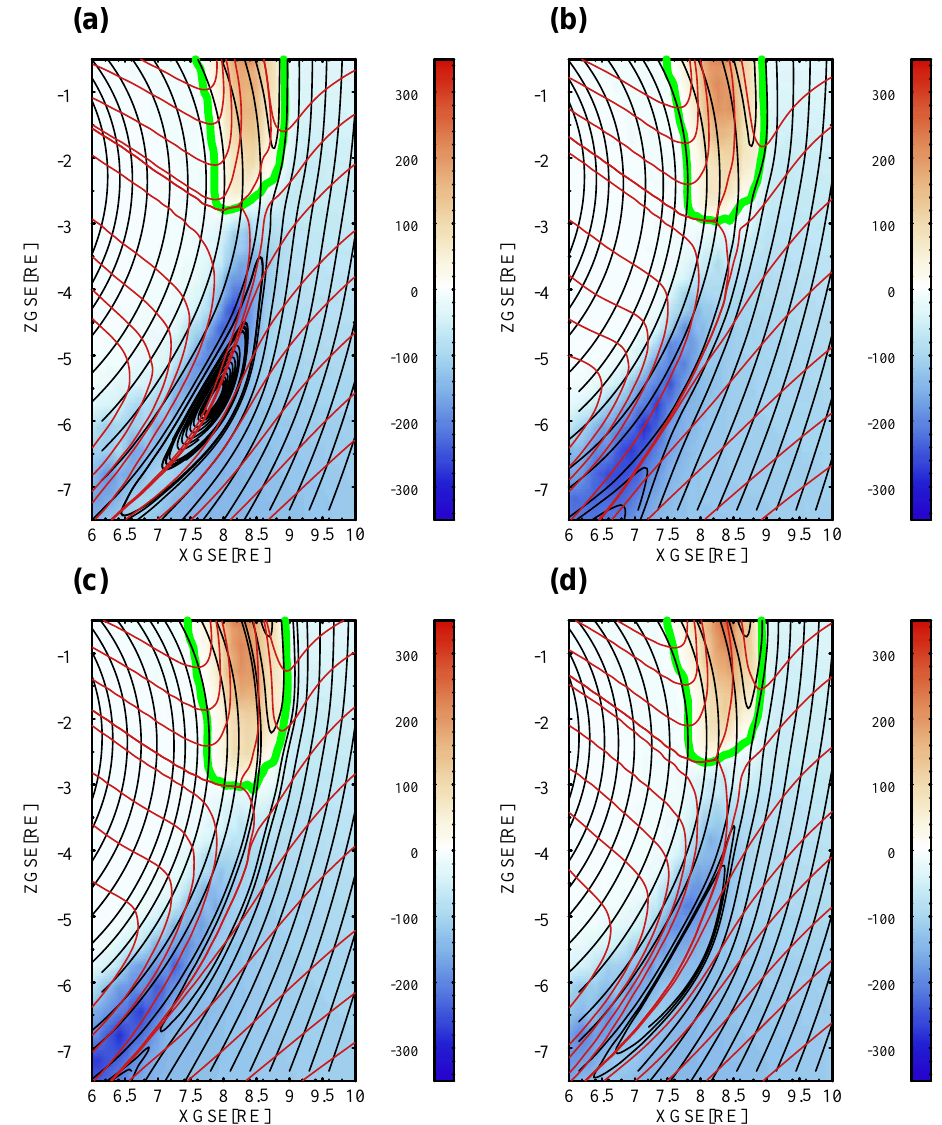
Fig. 3. The four panels show cuts in the noon-midnight meridional plane at different times. In each of the panels the color coding represents the Z-component of the plasma velocity in km/s. The thick green line is the zero contour of the plasma velocity Z-component. The black lines are field lines, i.e., these lines are tangent to the magnetic field direction in the Y=0 plane. The red lines are flow lines, i.e., these lines are tangent to the instantaneous velocity direction in the Y=0 plane. These snapshots were taken at different times: (a) t=t 0 =3260s, (b) t=3360s=t 0 +100s, (c) t=3400s=t 0 +140s, (d) t=3610s=t 0